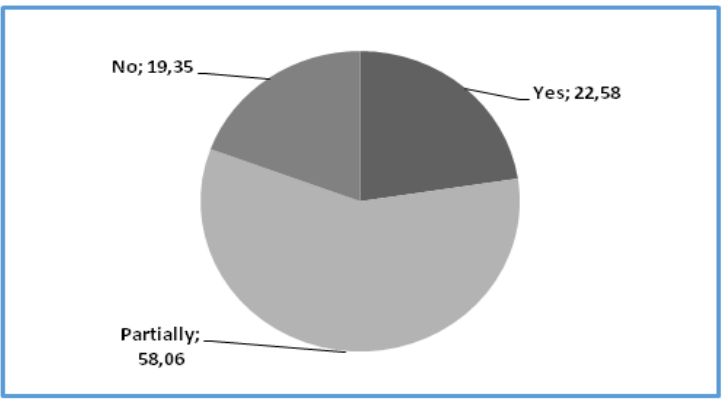
Fig. 6. Percentage of Responses Related to Managing Interaction with and Between